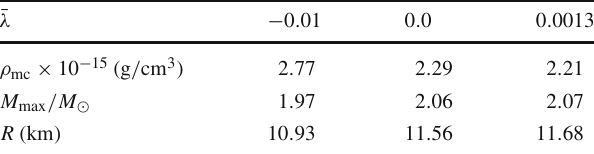
Table 7 The maximum masses and the corresponding radii for three- form field Bose–Einstein stars with constant potential ¯